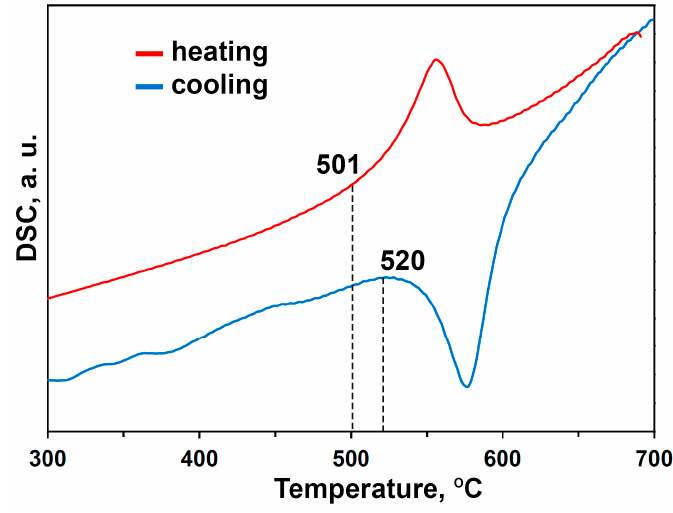
Figure 2. DSC curves in the heating/cooling cycles for Ca 8 MnEu(PO 4 ) 7 . The heating/cooling rate is 10 K/min.